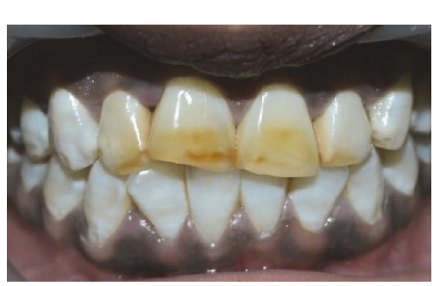
Figure 4: Pretreatment photograph showing discolored